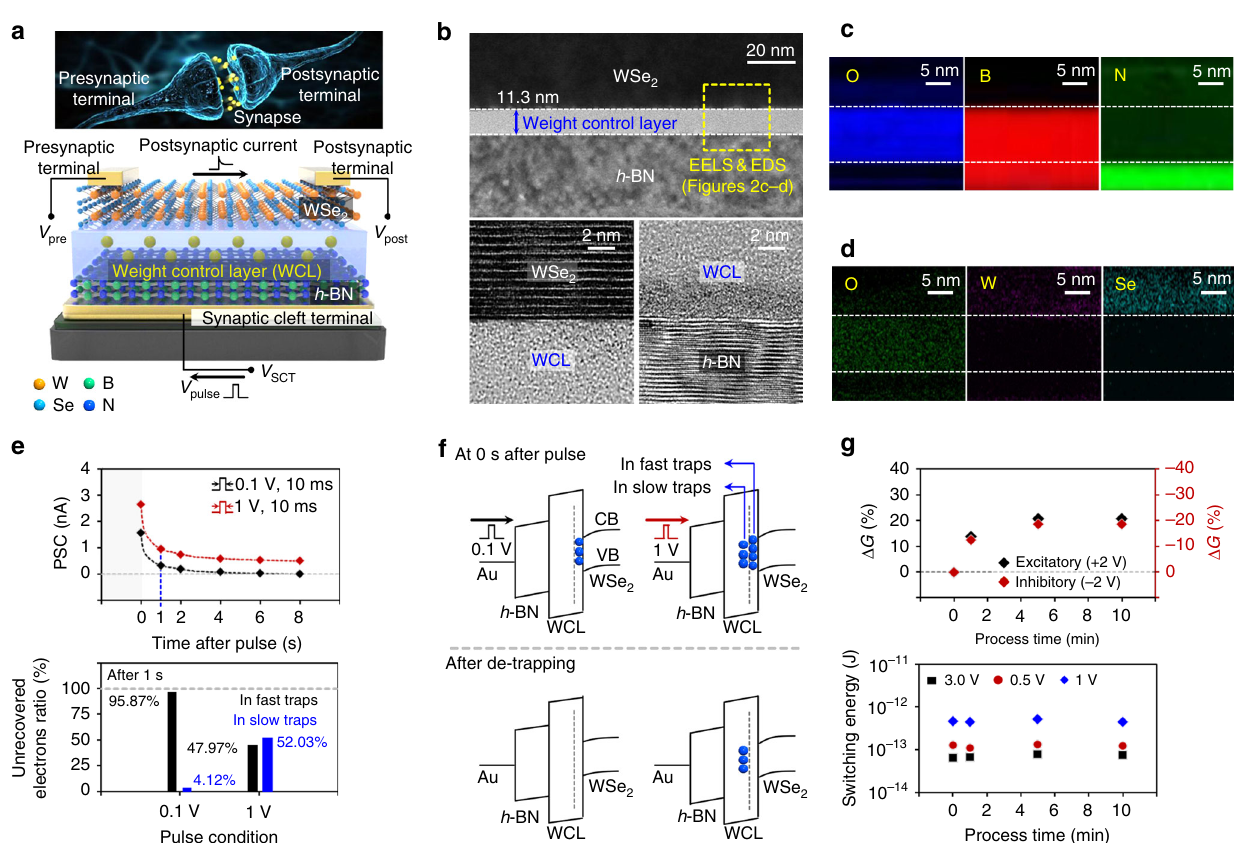
Fig. 2 Structure and operating mechanism of the h -BN/WSe 2 synaptic device. a Functional/structural/architectural comparison of biological synapse with our synthetic WSe 2 /WCL/ h -BN synaptic device. b X-TEM image of the WSe 2 /WCL/ h -BN structure, and the high-resolution images corresponding to the WSe 2 /WCL and WCL/ h -BN interfaces. c , d EELS ( c ) and EDS ( d ) mapping images obtained on the cross-section of the WSe 2 /WCL/ h -BN structure. e Current relaxation curves after pulse amplitudes of 0.1 V and 1 V, and contribution ratio from unrecovered electrons in fast traps and slow traps at 1 s after the pulse. f Illustration of energy band diagrams after pulse and after de-trapping of carriers in fast traps. g Change in postsynaptic conductance and